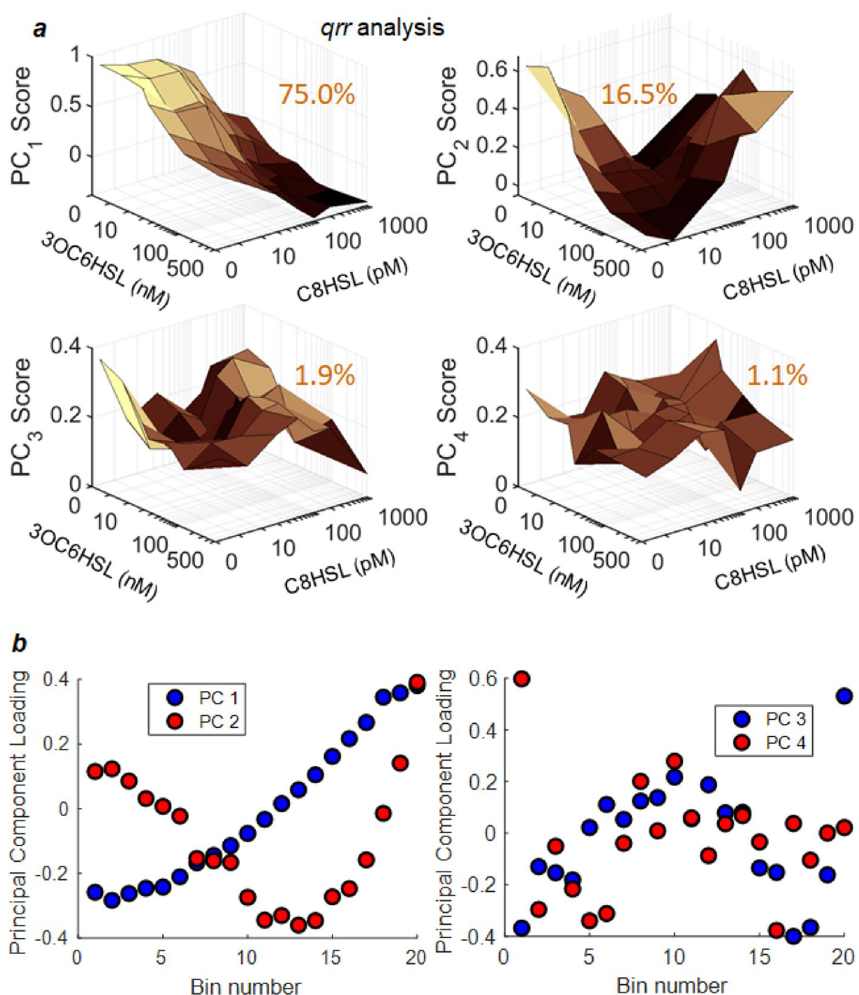
Figure 4. Principal component analysis (PCA) of the set of qrr reporter fluorescence histograms. Under each of 49 combinations of C8HSL and 3OC6HSL concentrations, the fluorescence measurements for ~ 400 individual cells were histogrammed into 20 bins and a square root transformation was applied to the bin heights ( Methods ). The PCA of the complete set of histograms then provides (a) scores for each principal component as a function of HSL input condition, and (b) loadings associated with each PCA component. The loadings describe the fluorescence-dependence described by each PCA component, and the scores describe the HSL dependence of that component. The percentage of data variance explained by each PCA component is indicated on the panel. The first four PCA components only are shown; these together account for 94.5% of the variance in the dataset (see text). HSL axes in (a) switch from linear to logarithmic at 10 concentration units 48